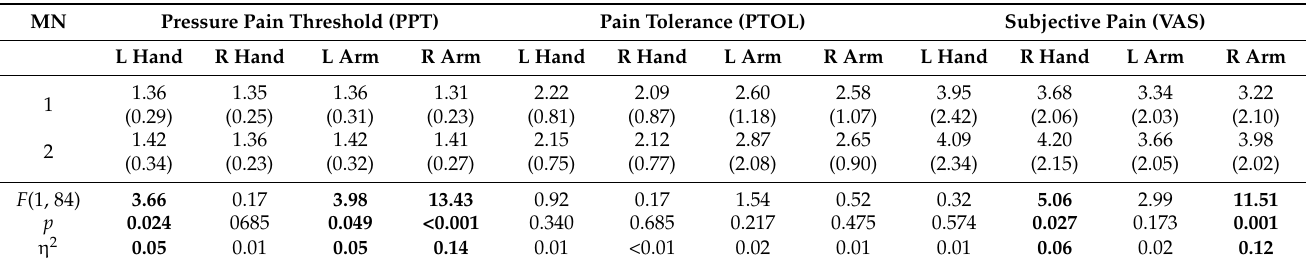
Table 2. The effect of the physical training ( N =